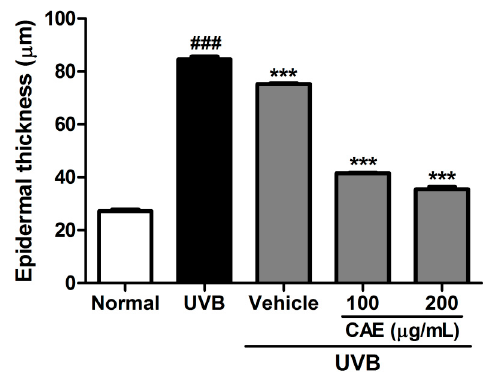
Figure 15. Skin thickness of hairless mice after CAE treatment. Significant difference versus the normal group: ###, p < 0.001; significant difference versus the UVB-induced group: ***, p < 0.001.